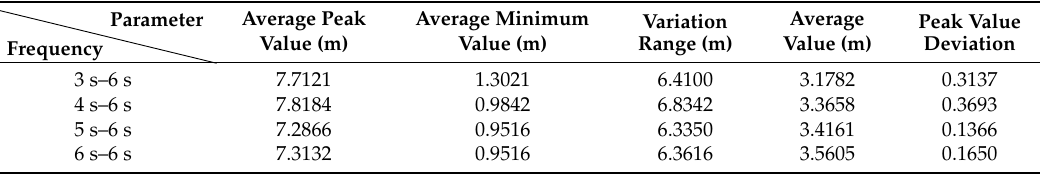
Table 10. Pressure values and statistical analysis after air inflow has been cut off for 6 s when the slot nozzle is set on top of the pipe.